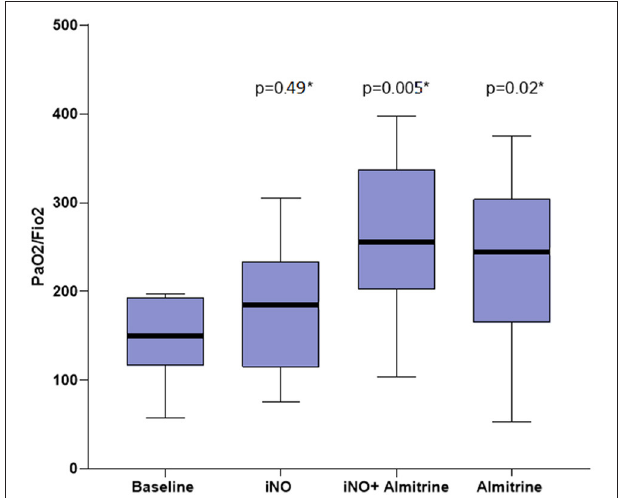
FIGURE 1 | Arterial partial pressure of oxygen/fraction of inspired oxygen (PaO 2 /FiO 2 ) evolution, *comparison from